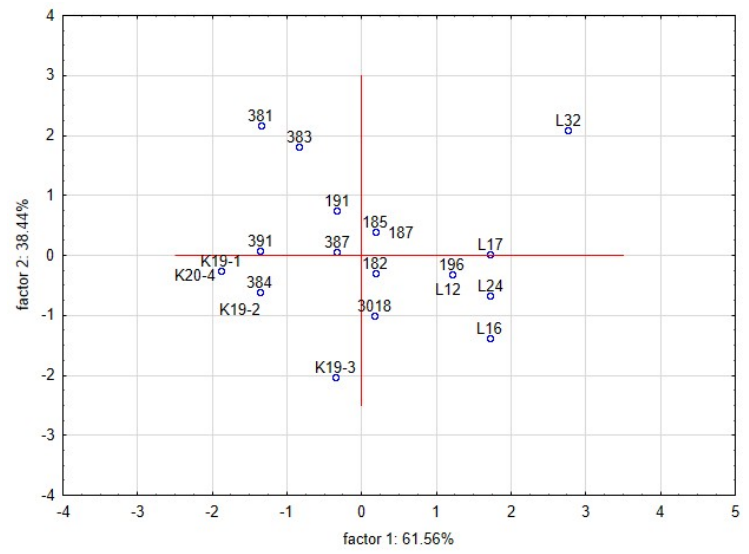
Figure 5. Principal component analysis (PCA) on the standardised value of index logarithms rep- resenting the interaction among lactobacilli and yeast contaminants in the overlay method. Scatter plot of the position of strains of L. plantarum is based on correlations among its functional properties. The interaction between the L. plantarum strains and yeast contaminants under the RSM conditions significantly influenced the average size of yeast colonies (mm). All L. plantarum strains significantly suppressed the growth of yeast colonies compared with the control (Figure 6, Table 8).